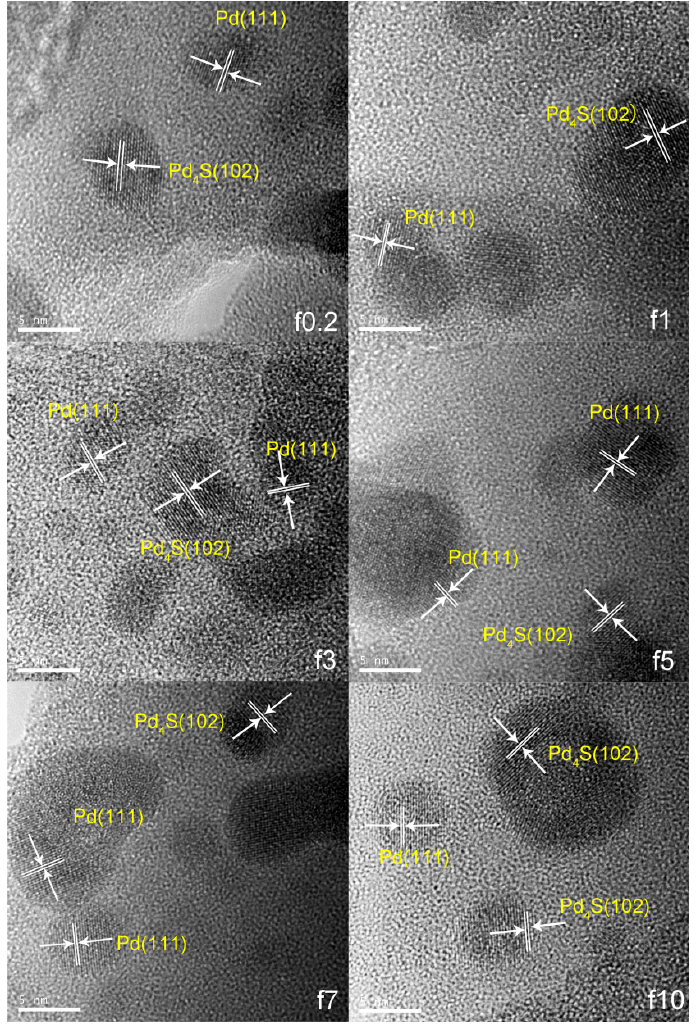
Figure 2. High resolution transmission electron microscopy (HR-TEM) images of freshly prepared catalysts with different H 2 S concentration.